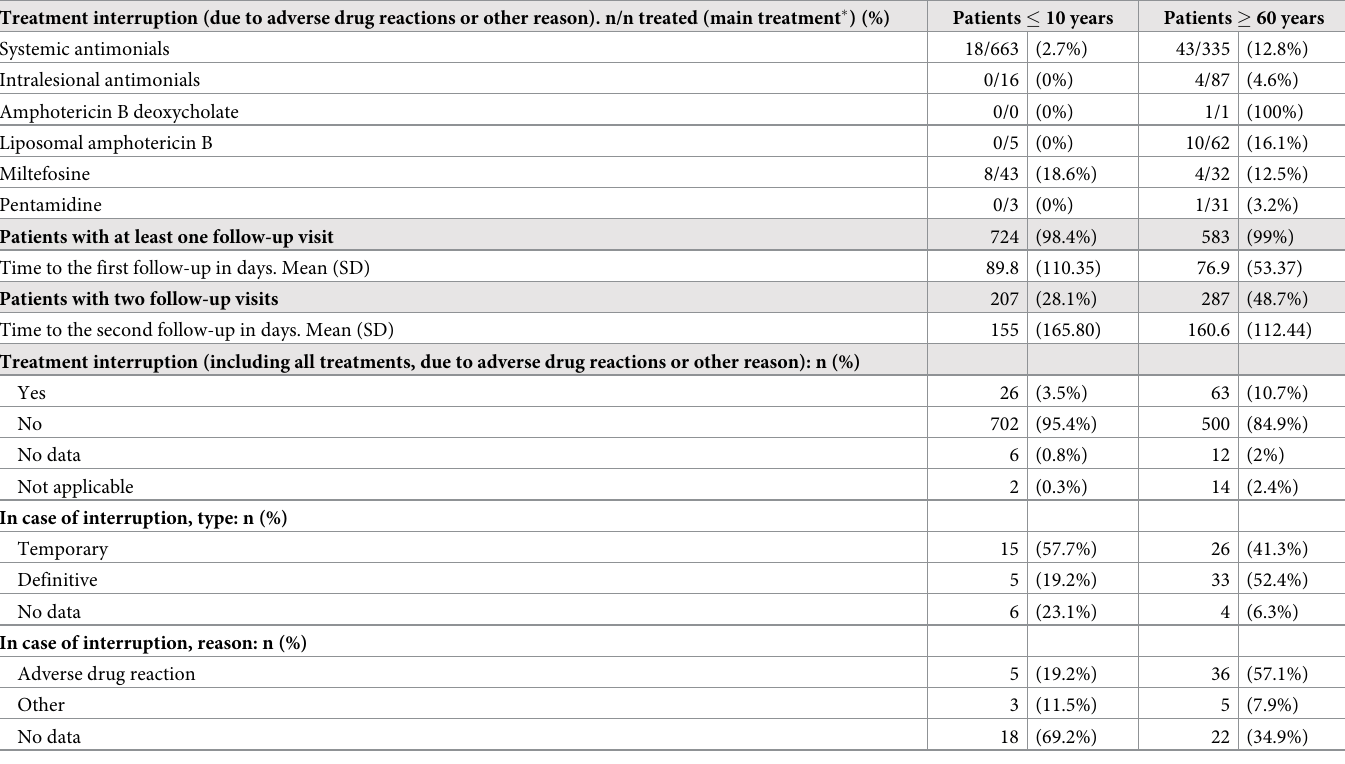
Table 3. Treatment interruption per treatment regimen and age